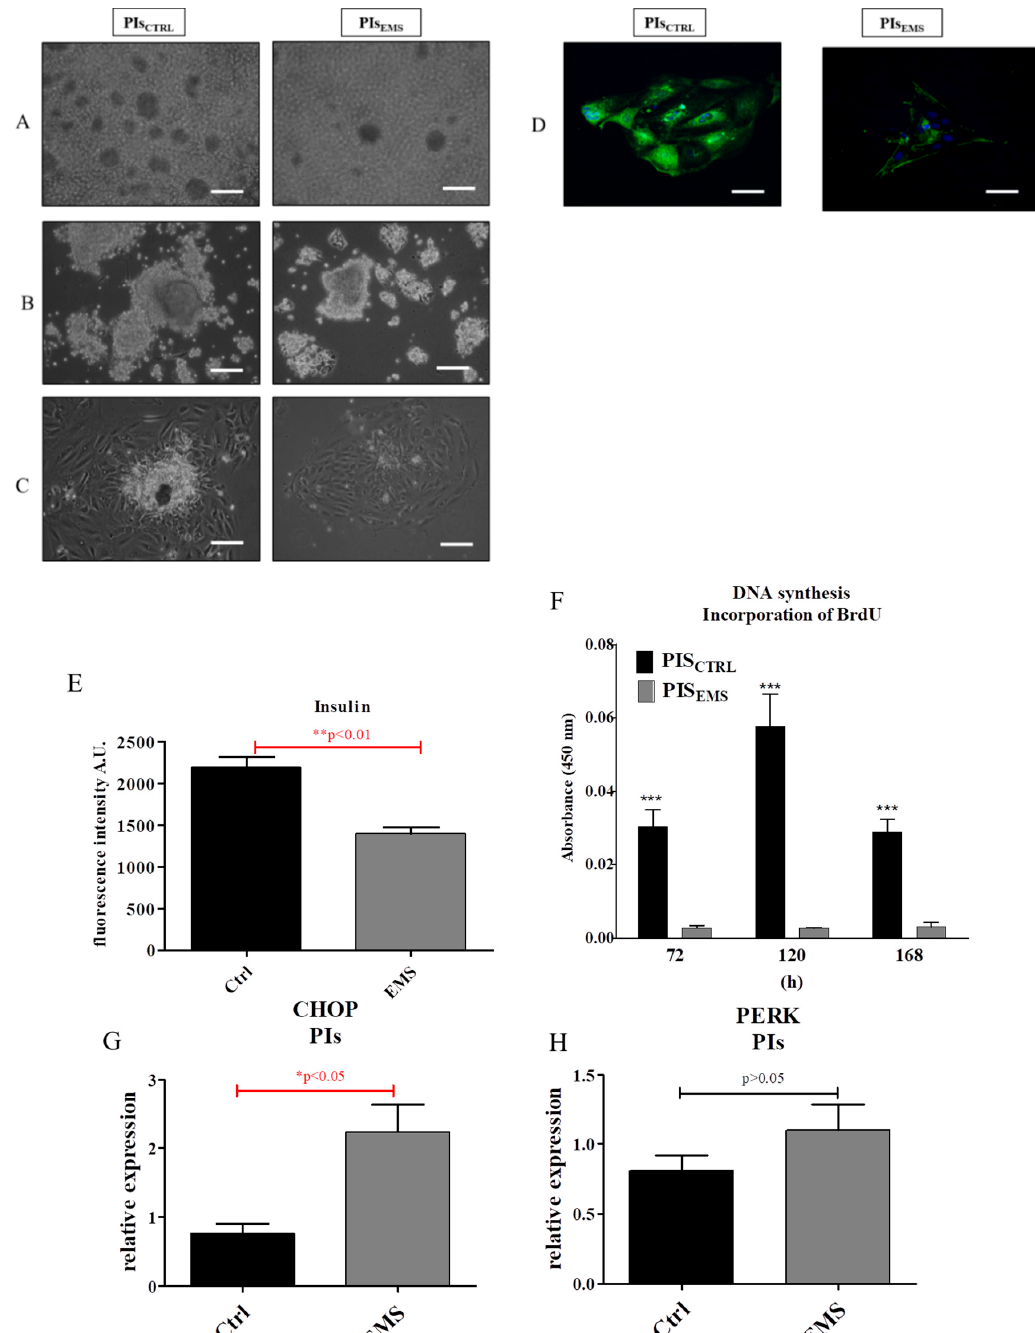
Figure 3. Morphology and proliferation of PIs in culture. The cultures were monitored after 72 ( A ), 120 ( B ) and 168 ( C , D ) h in culture. Immunofluorescence staining for insulin ( E ) was quantified using ImageJ by the meaning of fluorescence intensity. The obtained data indicate decreased insulin secretion by PIs EMS ( F ). Proliferation of cells was established using BrdU assay which indicates DNA synthesis rate. In the control group we observed increased BrdU incorporation in comparison to EMS, where DNA synthesis remained at a similar level during propagation. Additionally, using qRT-PCR we established the expression of two genes involved in ER stress. The amount of both CHOP ( G ) and PERK ( H ) mRNA was increased in PIs EMS , but only CHOP showed a statistically significant difference ( p < 0.05). Scale bars: light microscope 400 µ m; confocal microscope 40 µ m. Results expressed as mean ± S.D. * p < 0.05, ** p < 0.01; *** p < 0.001